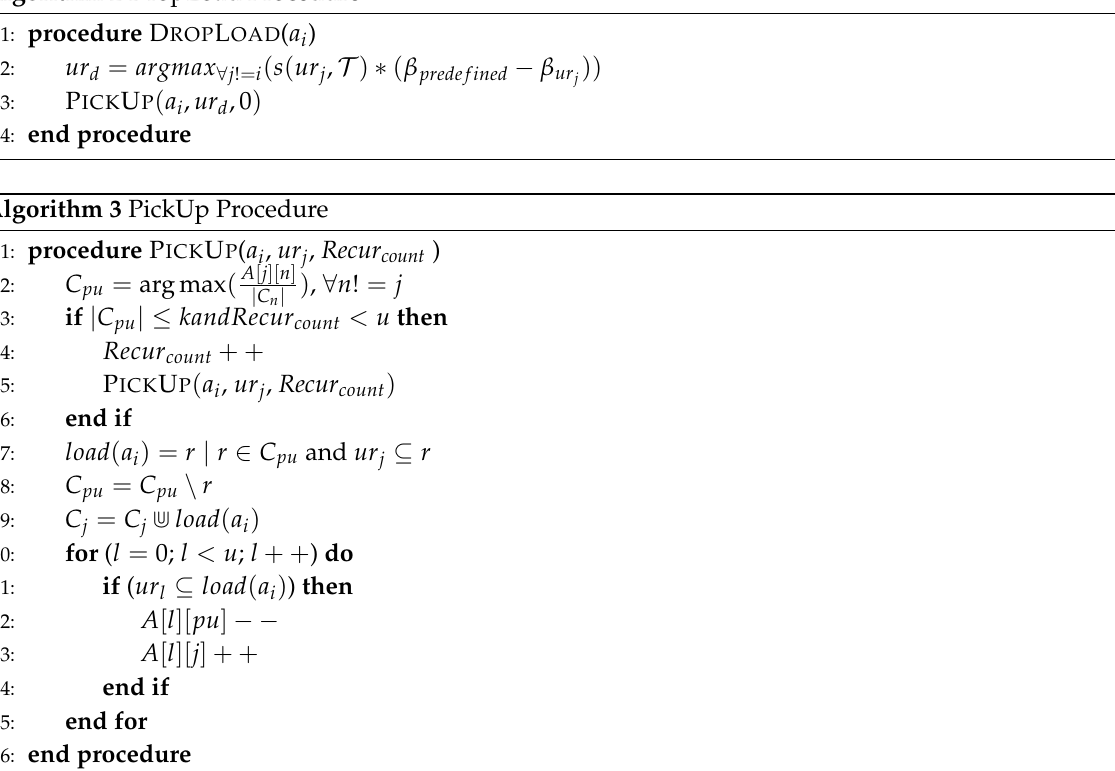
Algorithm 2 DropLoad Procedure